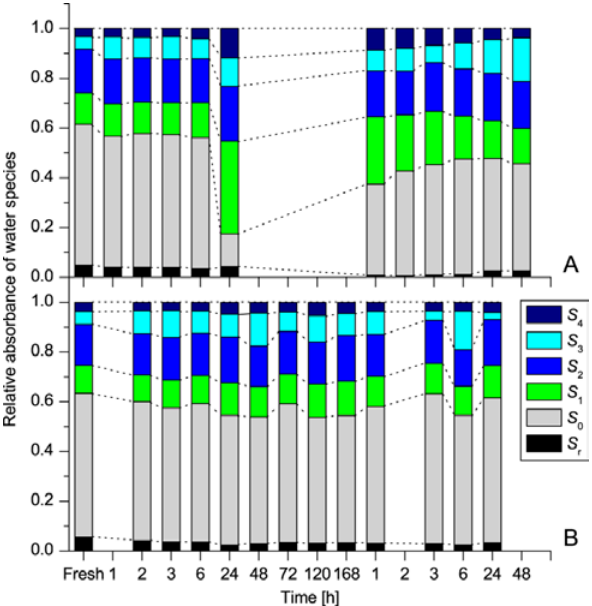
Figure 9. Dynamics of different water species (S i = water molecules with i hydrogen bonds, S r = protonated water clusters) during dehy- dration and rehydration of Haberlea rhodopensis and Deinostigma eberhardtii . Relative absorbance of water species in Haberlea rhodo- pensis (A) and Deinostigma eberhardtii (B) during desiccation and subsequent rehydration.